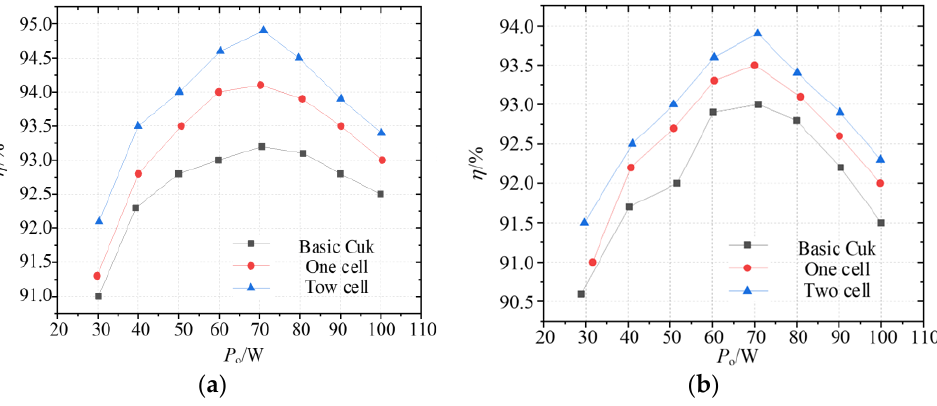
Figure 19. The efficiency curve of the prototype: ( a ) step-up mode; ( b ) step-down mode.